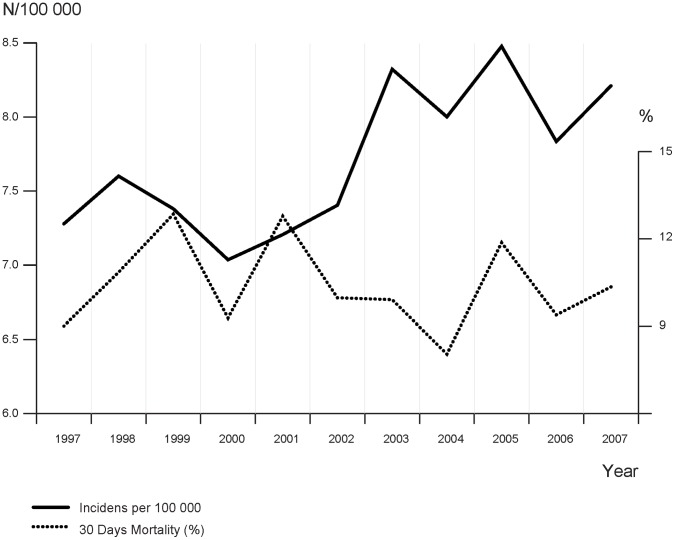
Incidence Rate and 30-days Mortality (%) of Infective endocarditis (IE) hospitalizations in Sweden during 1997 through 2007.